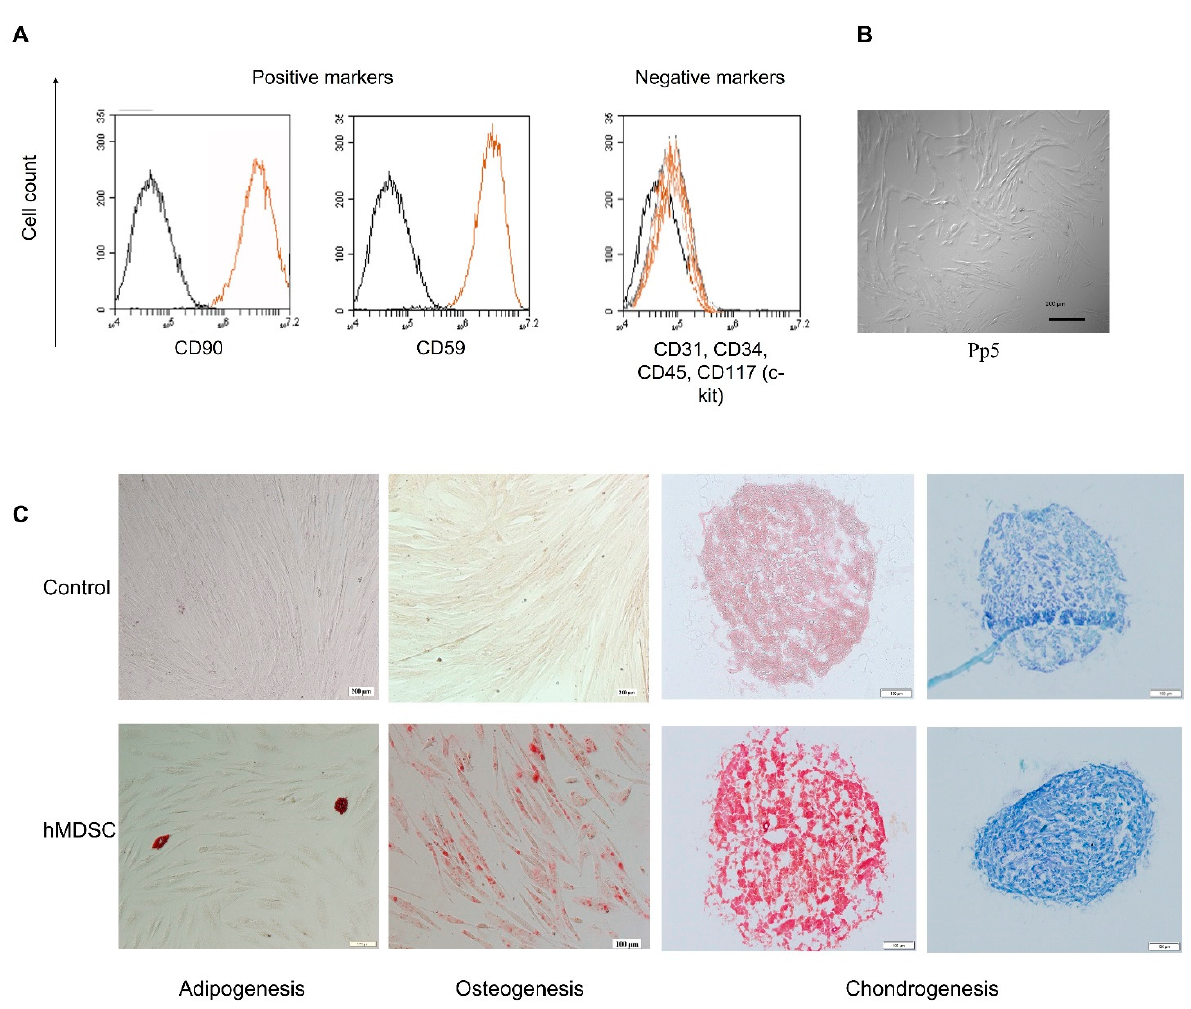
Figure 3. Characterization of isolated hMDSCs. The expression of specific stem cell markers was tested via FACS ( A ) and differentiated into adipocytes, osteocytes, and chondrocytes ( C ). Isolated cell (preplate 5, passage 5) morphology was identified via microscopy ( B ). A—black color—negative control, orange—stained; C—adipogenesis—Oil Red O staining; osteogenesis—Alizarin staining; chondrogenesis—safranin (orange-red) and toluidine blue (blue) staining. CD—a cluster of difference; pp5—preplate 5; hMDSC—human-muscle-derived stem cells. Scale bar—200 μ m.